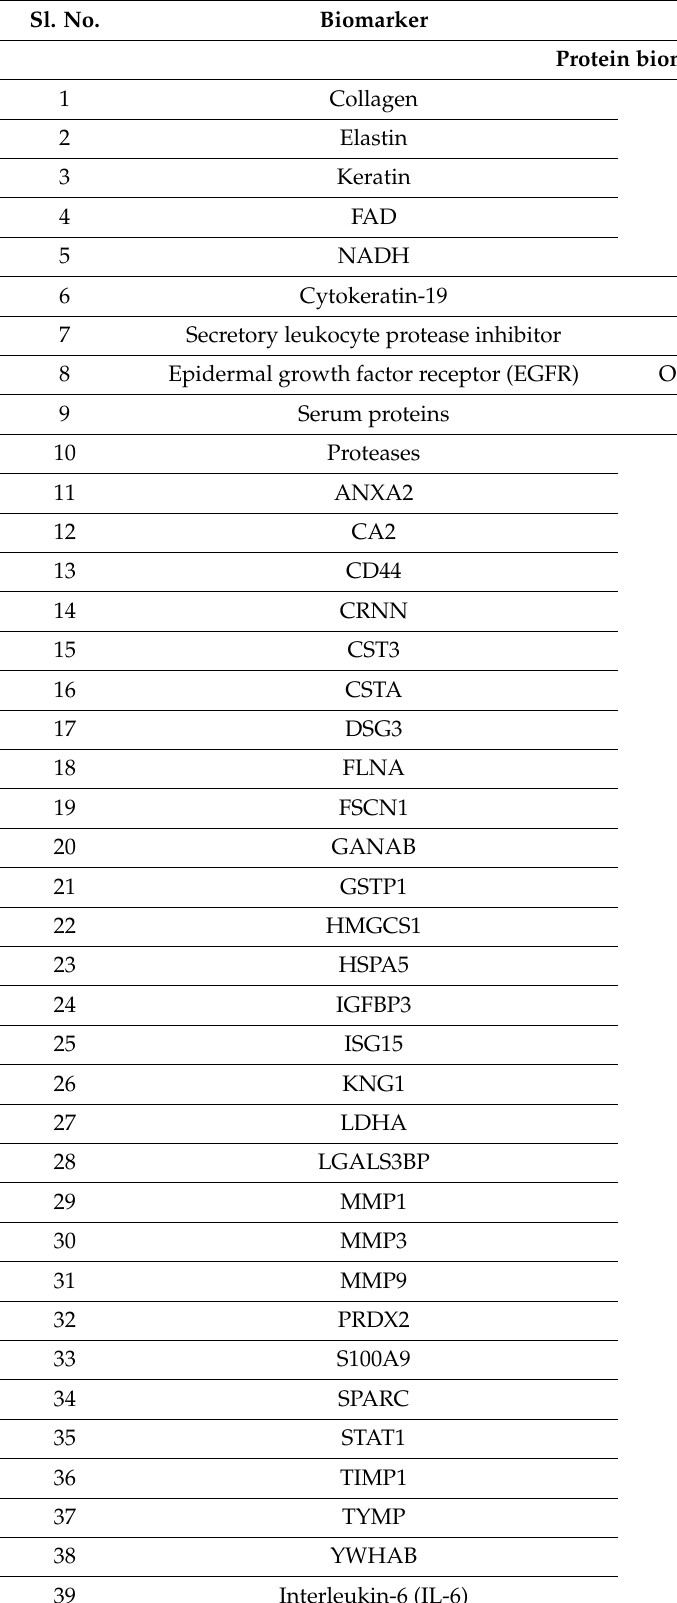
Table 2. Biomarkers associated with the data source and technologies used to identify oral cancer and